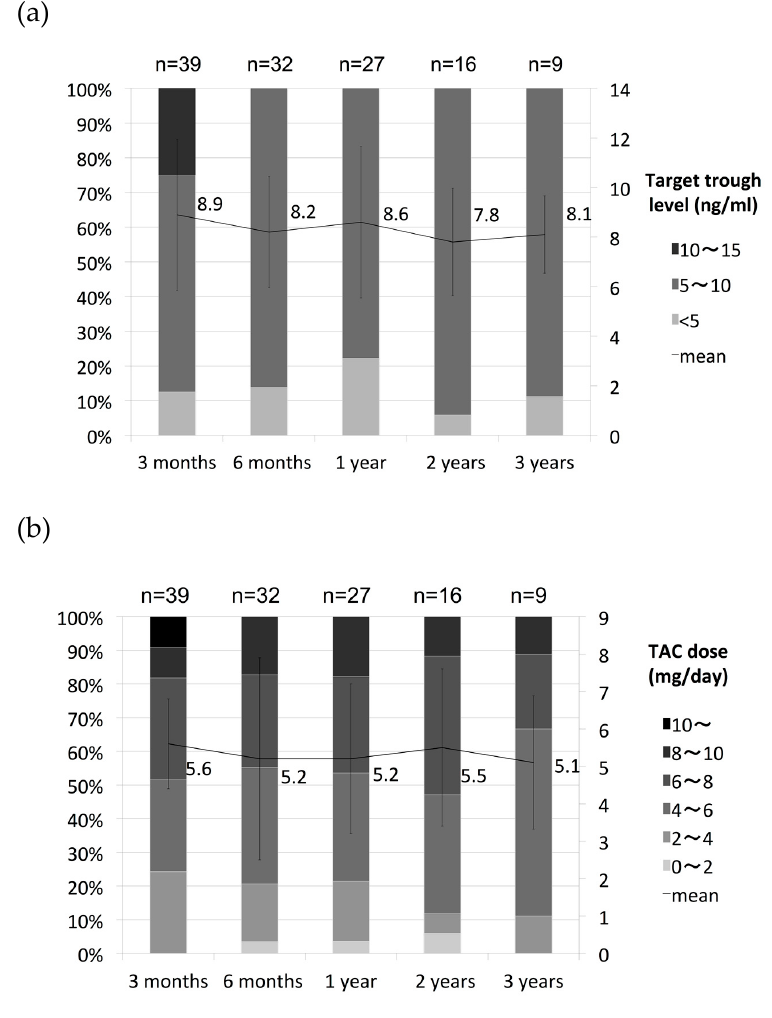
Figure 4. Transition of tacrolimus (TAC) trough level and dose. ( a ) Target through level; ( b ) TAC does. Whole-blood levels of TAC were maintained at a range of 5–10 ng/mL after trough level of 10–15 ng/mL for first 2 weeks to induce remission.